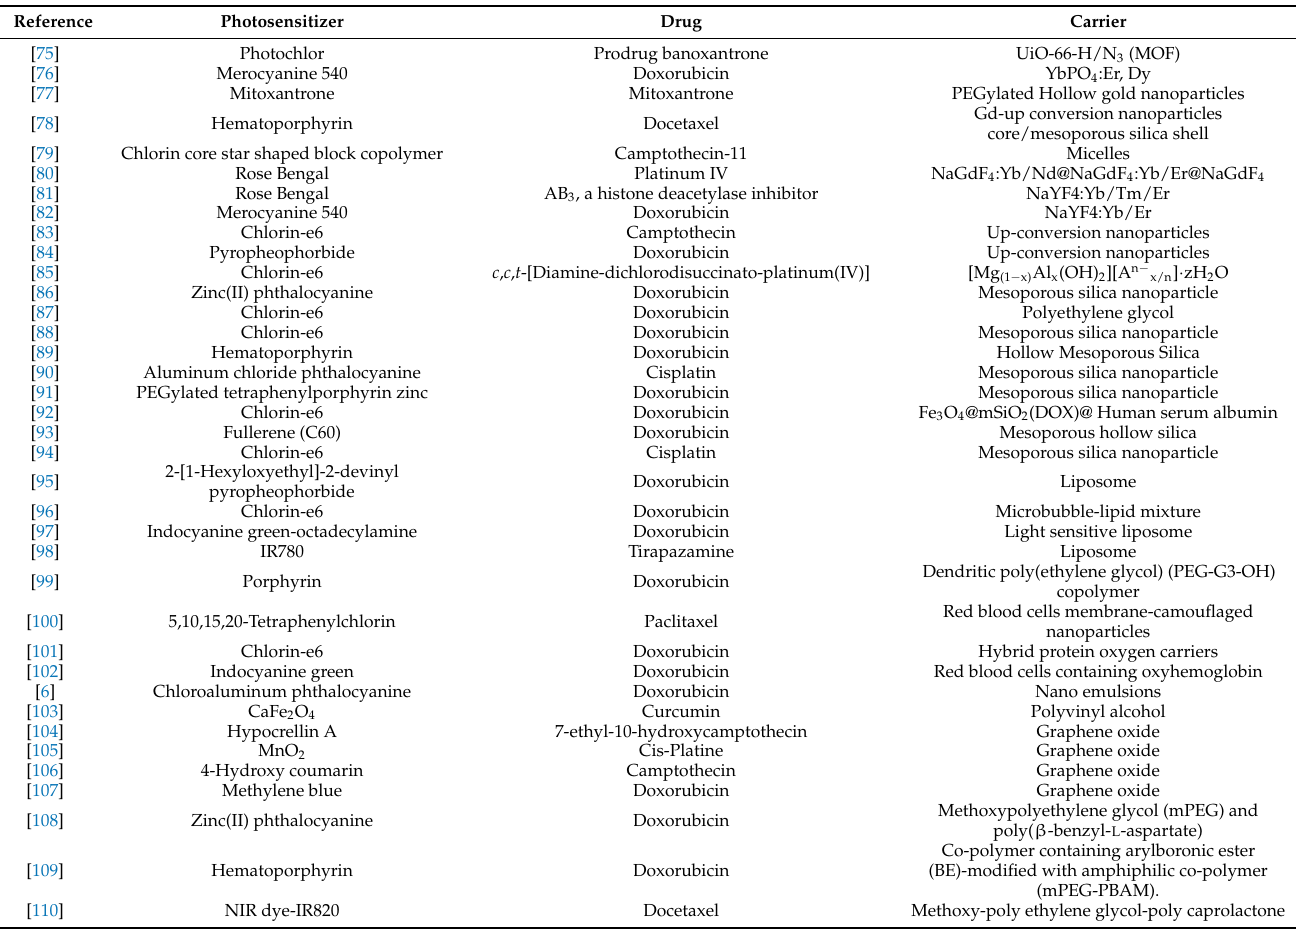
Table 3. Combination of photosensitizers and chemo-drugs with